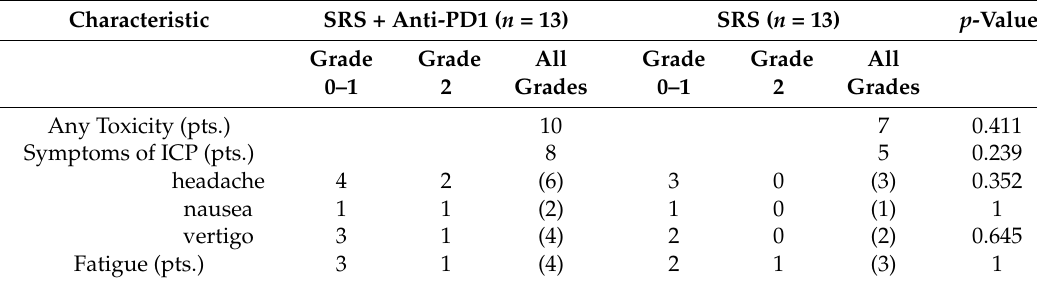
Table 3. Adverse